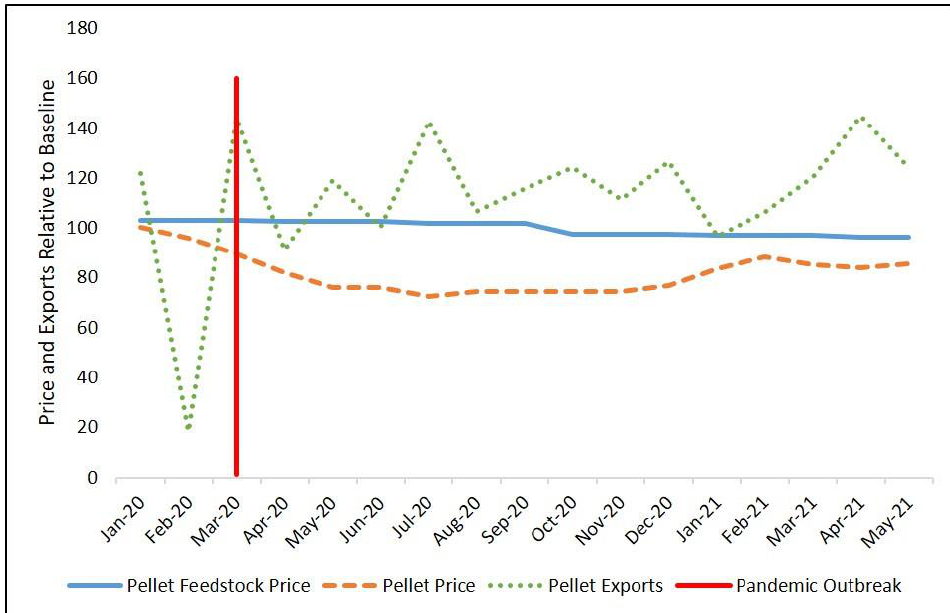
Figure 5. Canadian monthly wood pellet feedstock prices, wood pellet prices and wood pellet ex- ports.